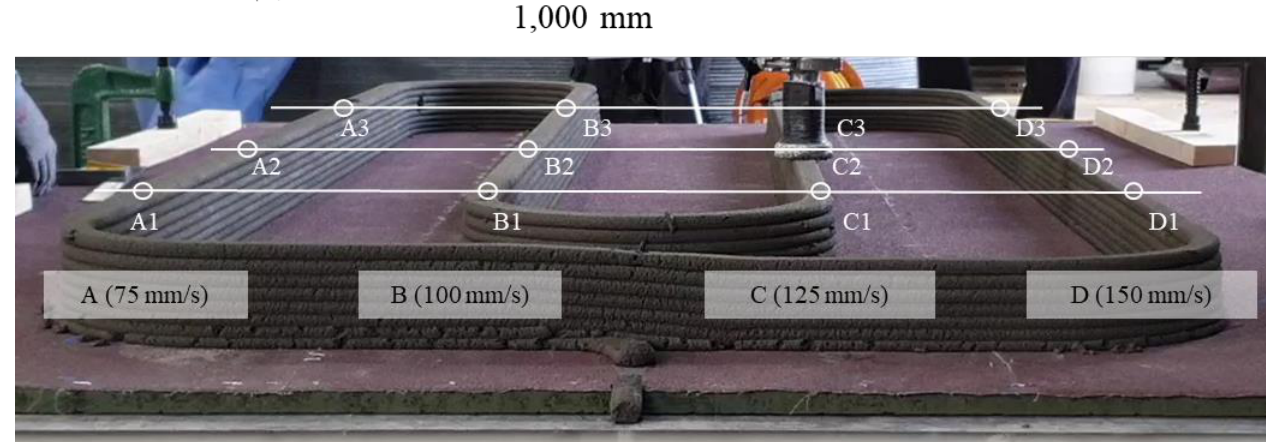
Figure 7. Printing design and measurement points.